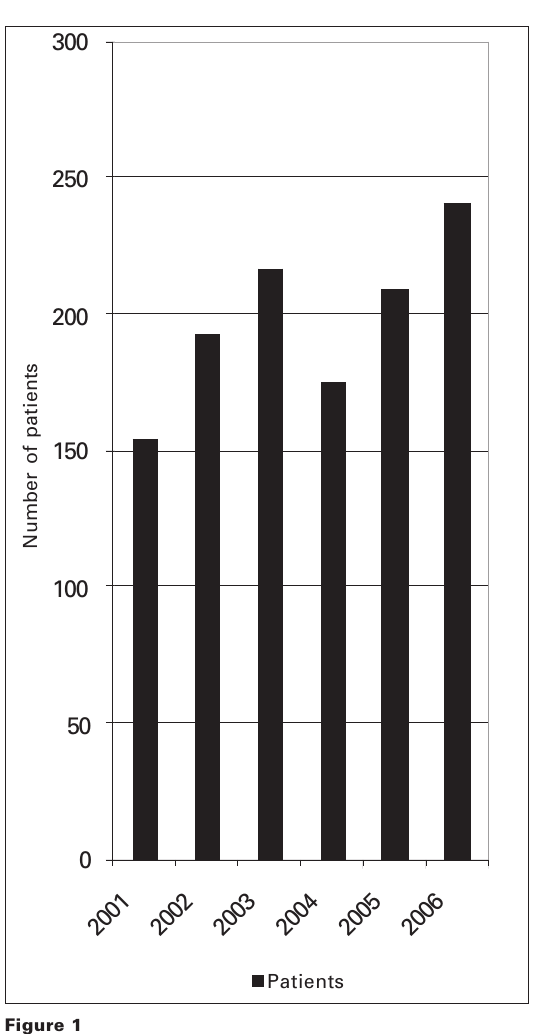
Figure 2 Nationality of patients [%] seen per